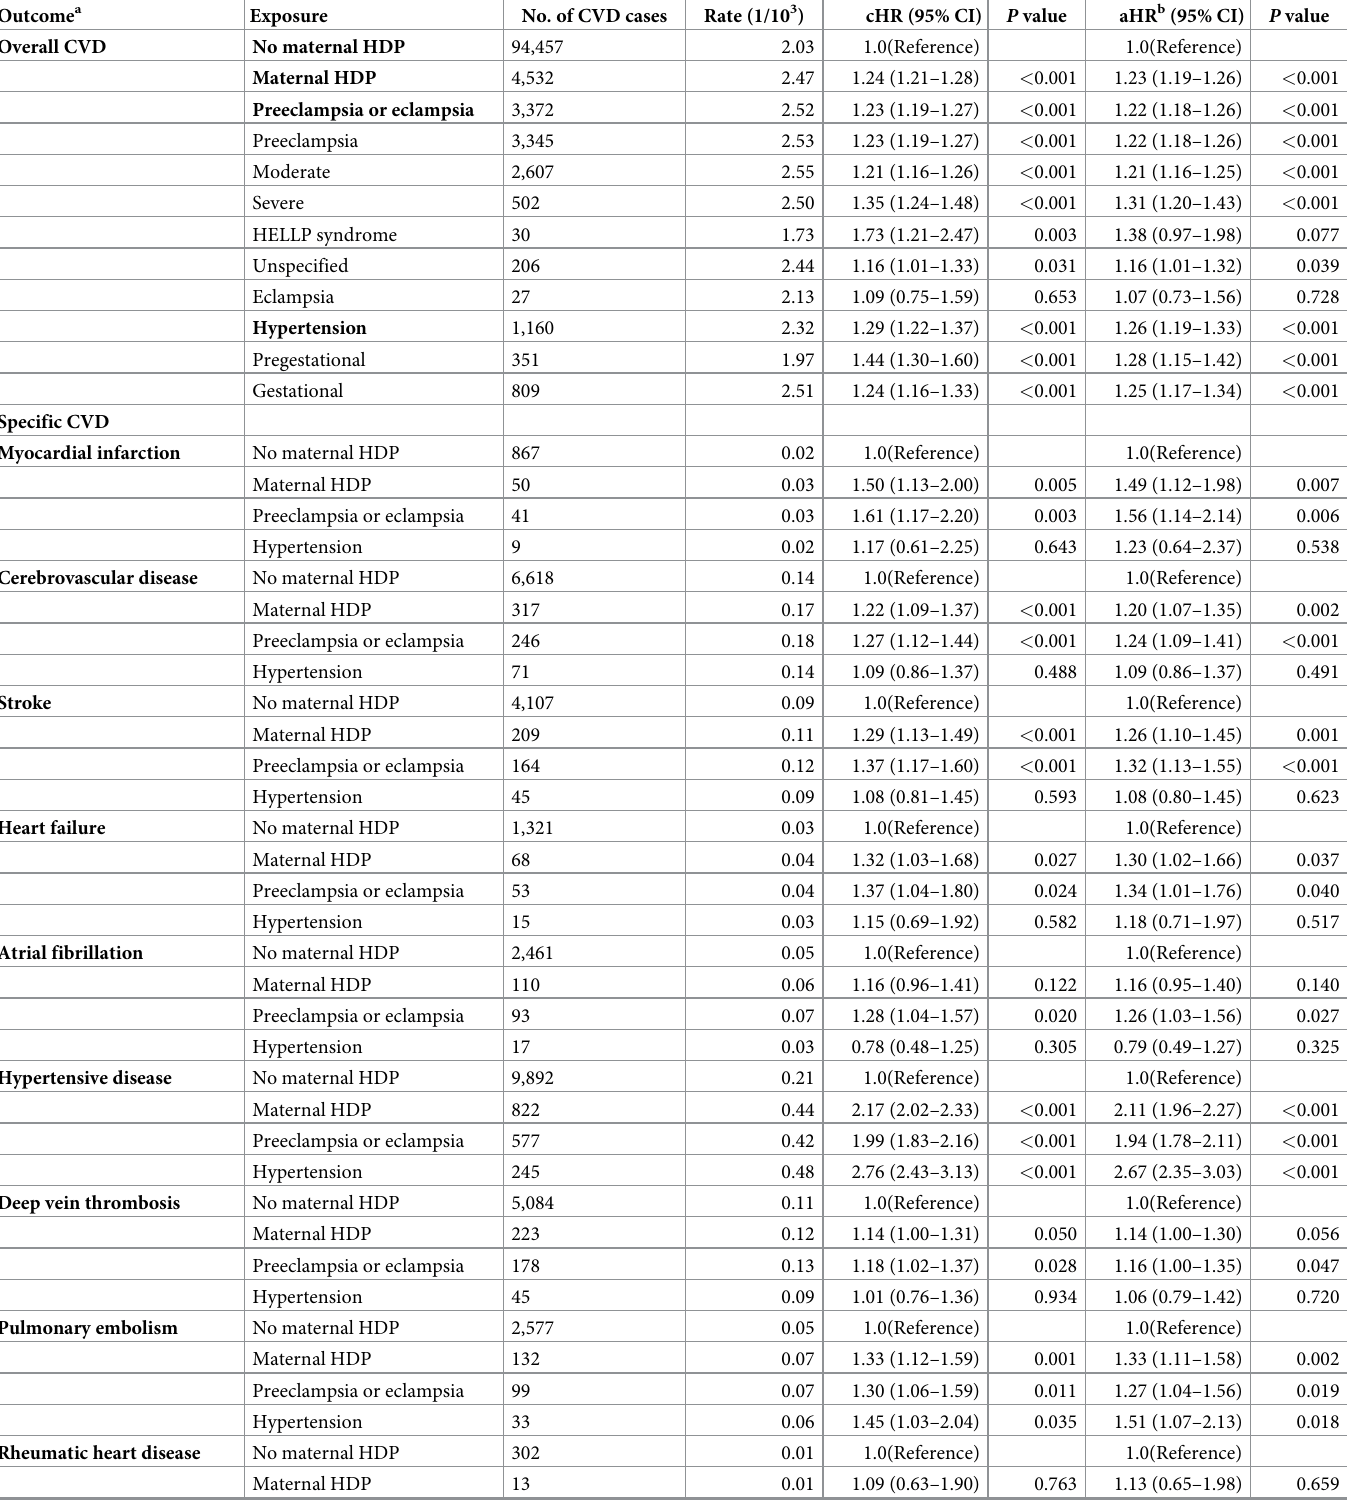
Table 2. HRs for associations between maternal HDP and overall early-onset CVD and type-specific CVDs in